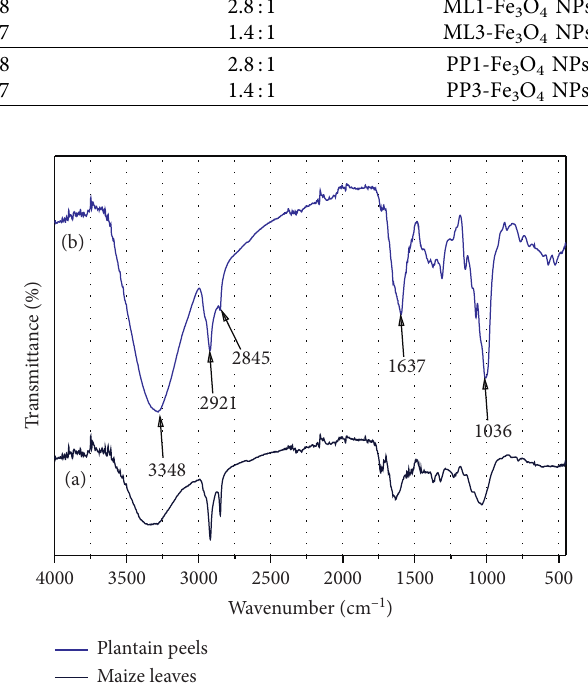
Figure 1: FTIR plot of extracts used in the synthesis. (a) Maize leaves. (b) Plantain peels.